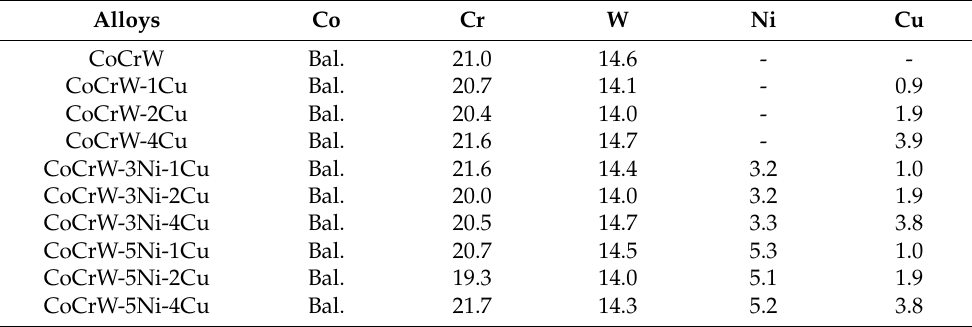
Table 2. Chemical composition of CoCrW-xNi-yCu alloys (wt.%). Alloys Co